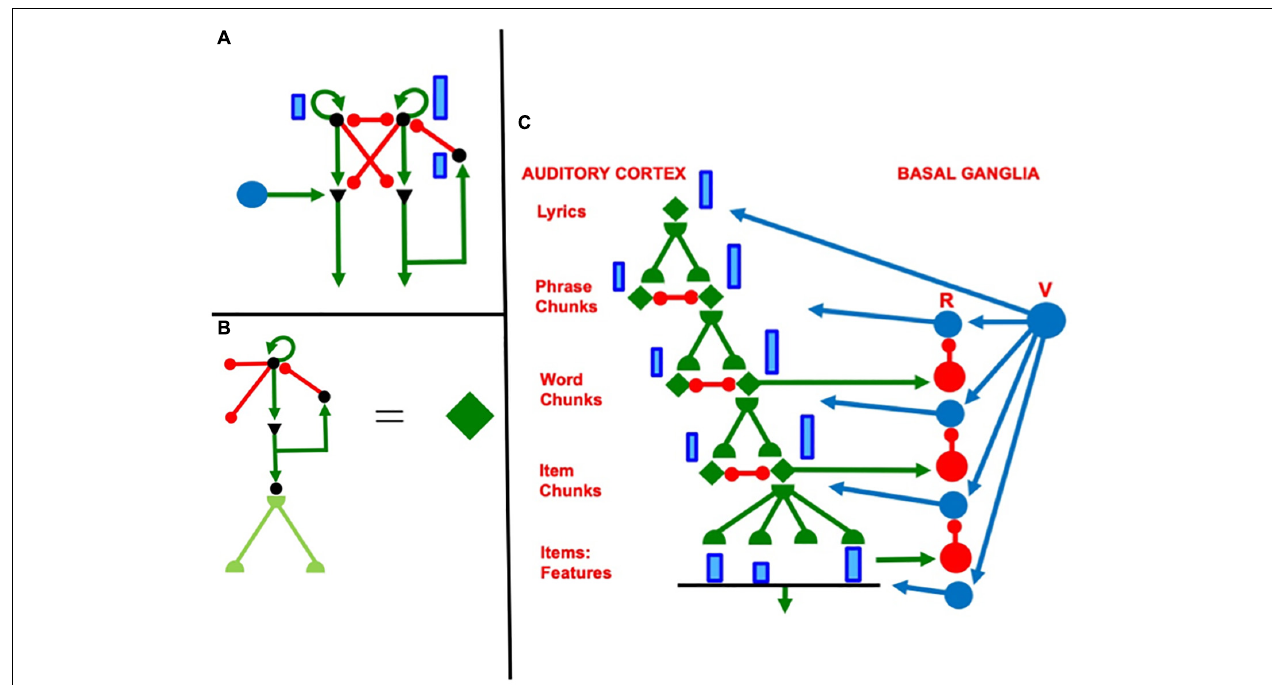
FIGURE 10 | (A) When a rehearsal wave R (blue disk) turns on, the item that is stored in working memory can be rehearsed while it self-inhibits its working memory representation. Relative activity amplitudes are represented by the sizes of vertical blue rectangles. Triangular cells are polyvalent. (B) Filled diamond summarizes key stages in choosing items to be rehearsed and associating them with bottom-up adaptive filter and learned top-down expectations. (C) Recursive read-out, under volitional control, from the hierarchy of processing stages that represents the lyrics of a song. Green represents excitatory connections. Red represents inhibitory connections. Blue disks represent volitional gain control signals. See the text for